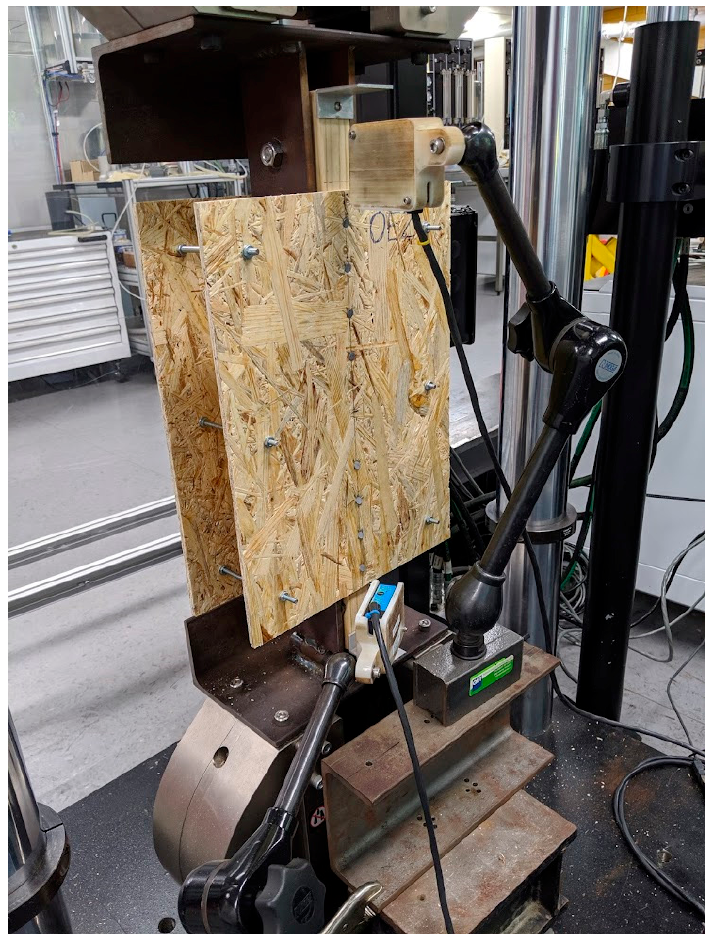
Figure 3. Test setup with unweathered OSB specimen (photo taken during test). Table 2. Loading rate for cyclic tests by